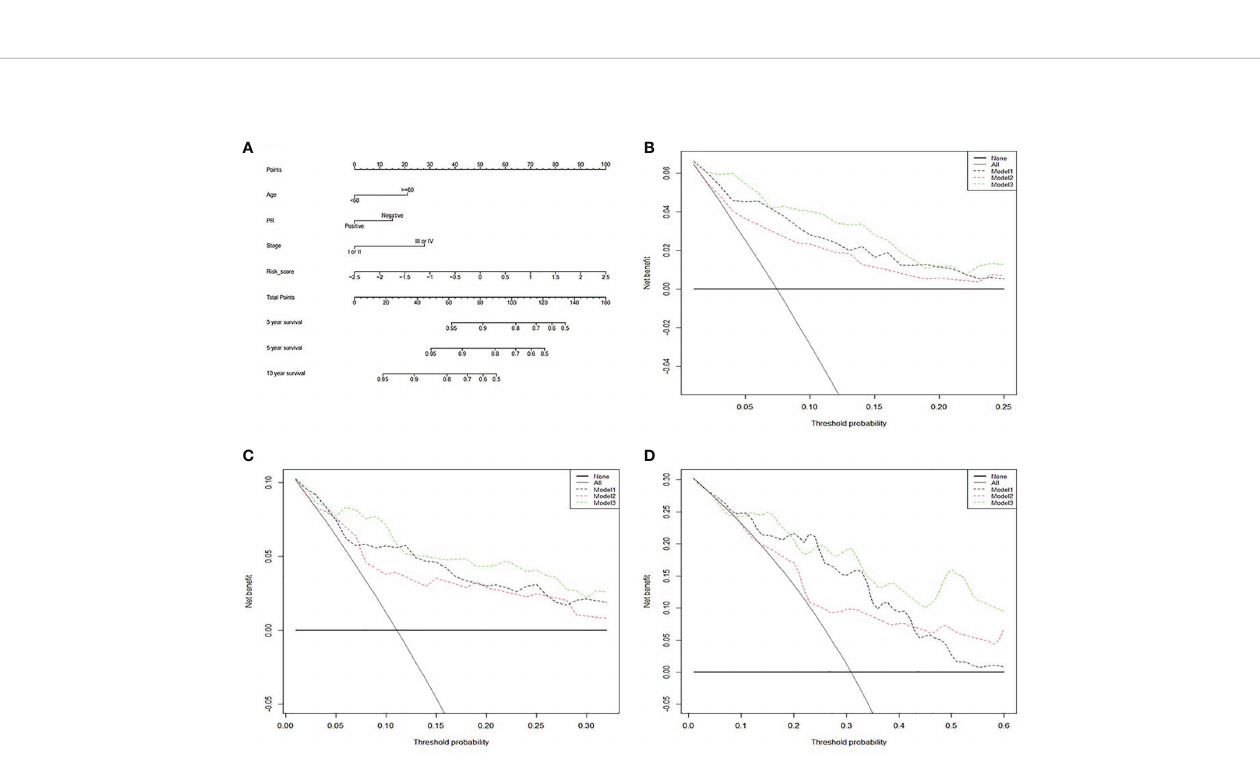
FIGURE 9 | The clinical application value of the survival prognosis gene signature. (A) Nomogram for predicting 3-, 5-, and 10-year survival of RT BRCA patients. (B) DCA curve in 3-, (C) 5-, and (D) 10-year using three